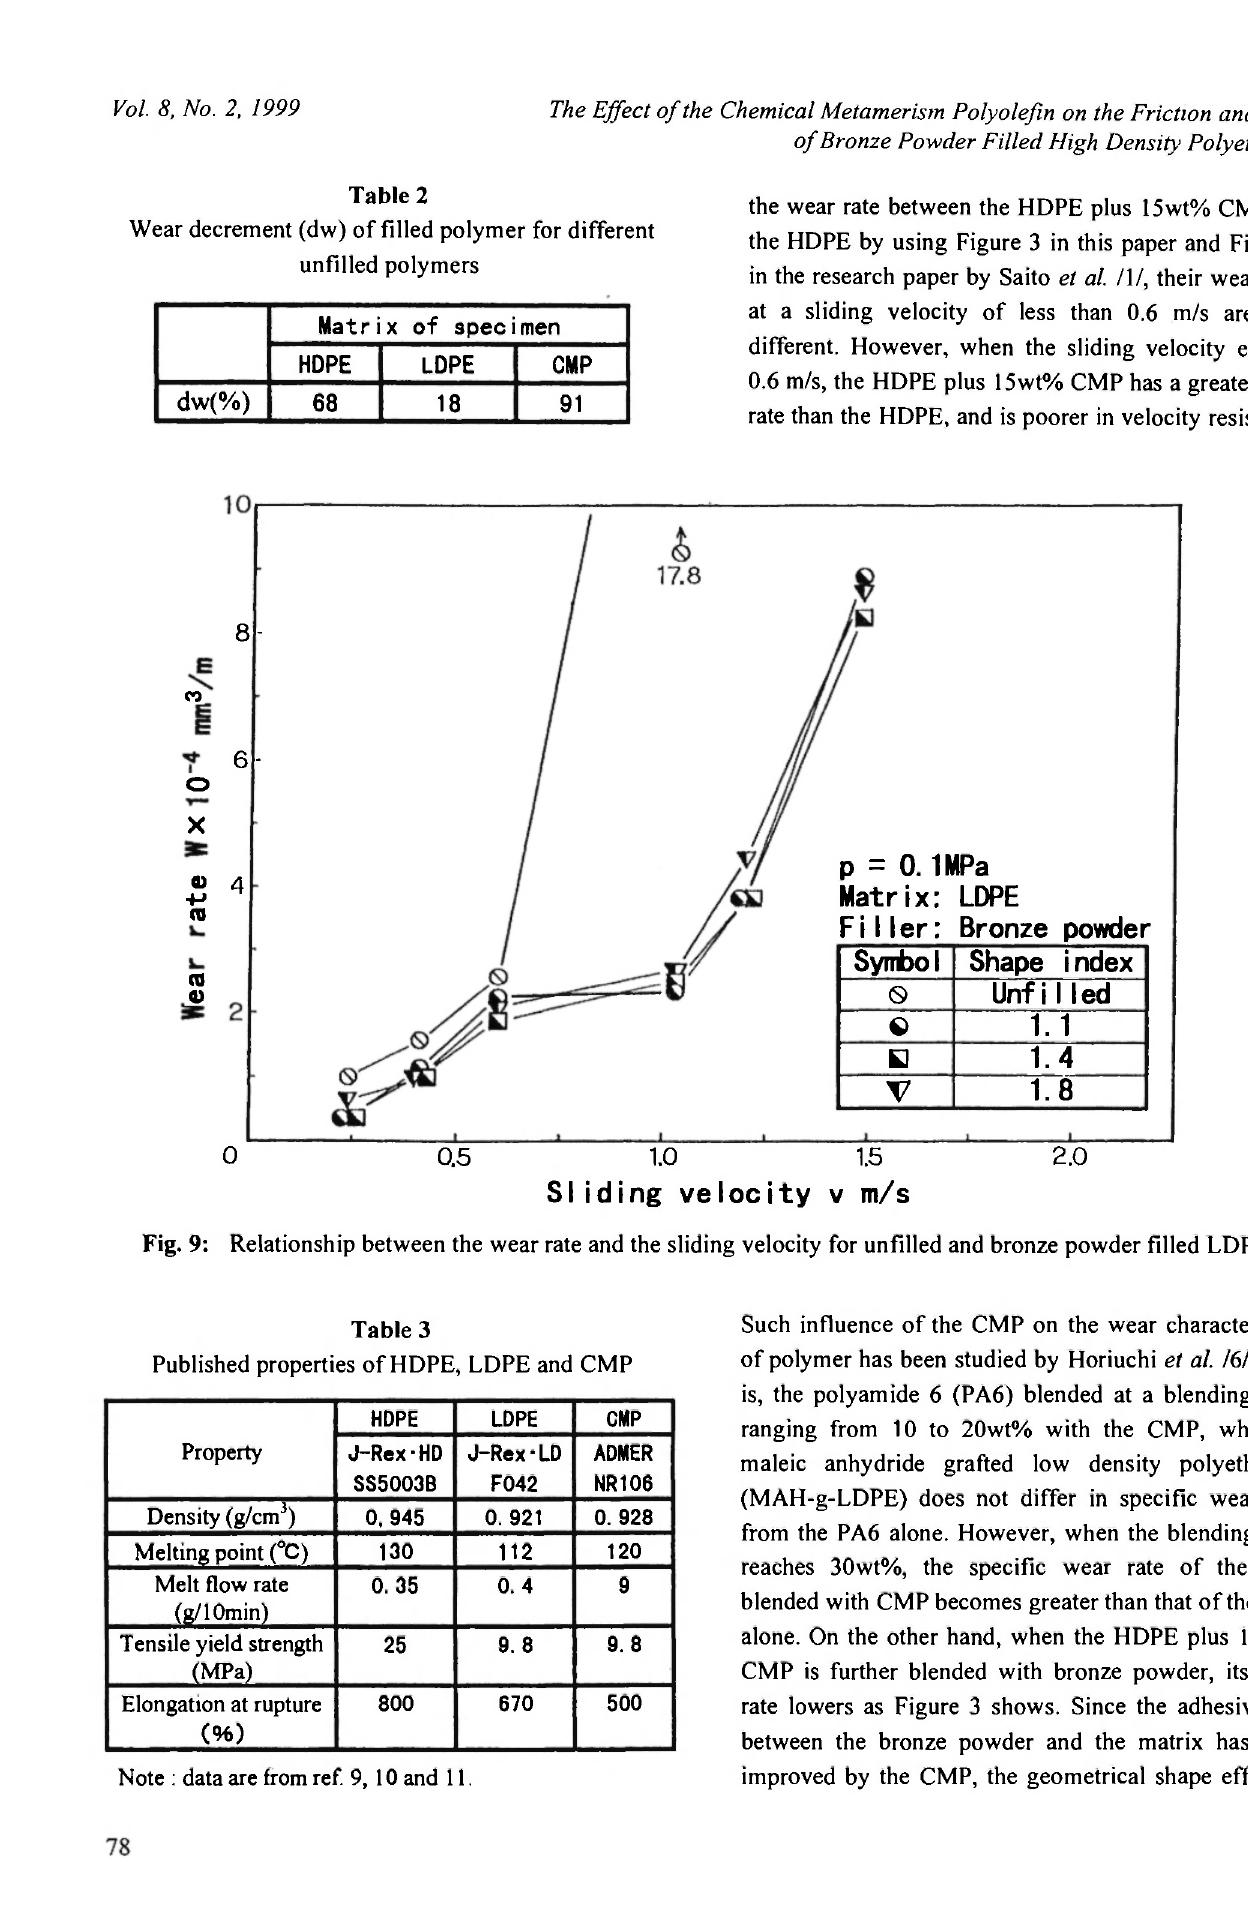
Wear decrement (dw) of filled polymer for different